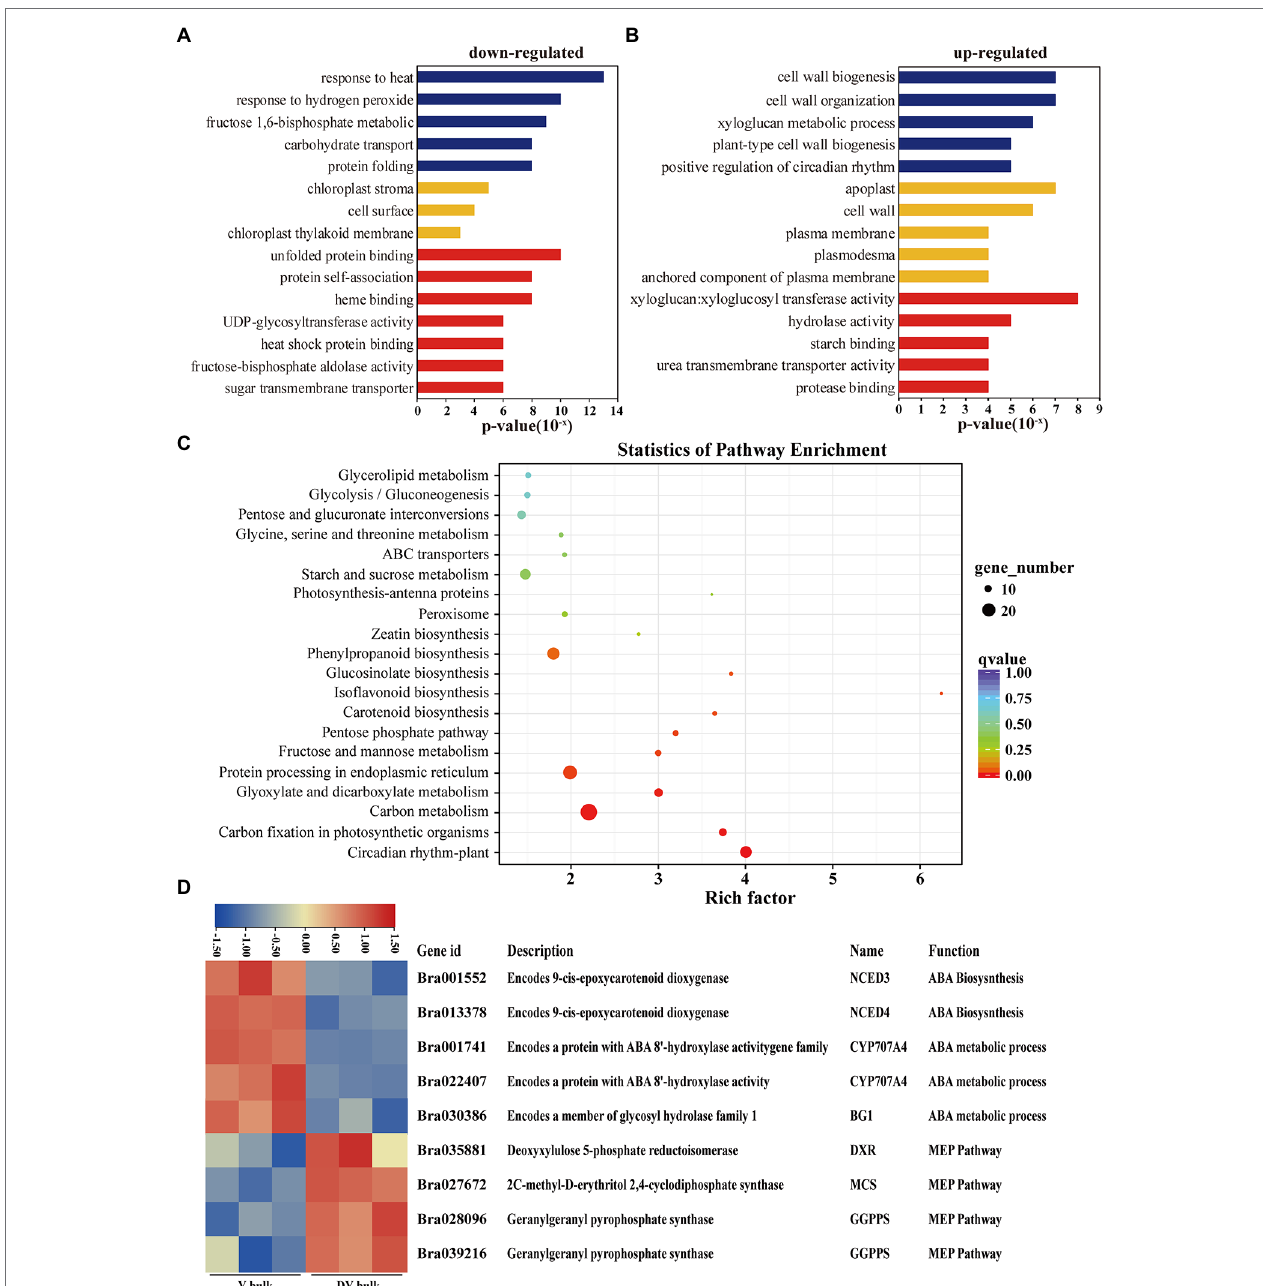
FIGURE 6 | Transcriptome analysis in yellow and dark yellow petals. (A,B) GO terms that were significantly enriched in 587 downregulated genes (A) and in 278 upregulated genes in the DY-bulk (B) . (C) Scatter plot of top 20 enriched KEGG pathways. Rich factor is the ratio of the DEG number to the background number in a certain pathway. The size of the dots represents the number of genes, and the color of the dots represents the range of the q -value. (D) Differentially expressed genes related to the carotenoid metabolism and flux. The heatmap colors are shown in log2 (FPKM). Three biological replicates of the W-bulk and G-bulk are